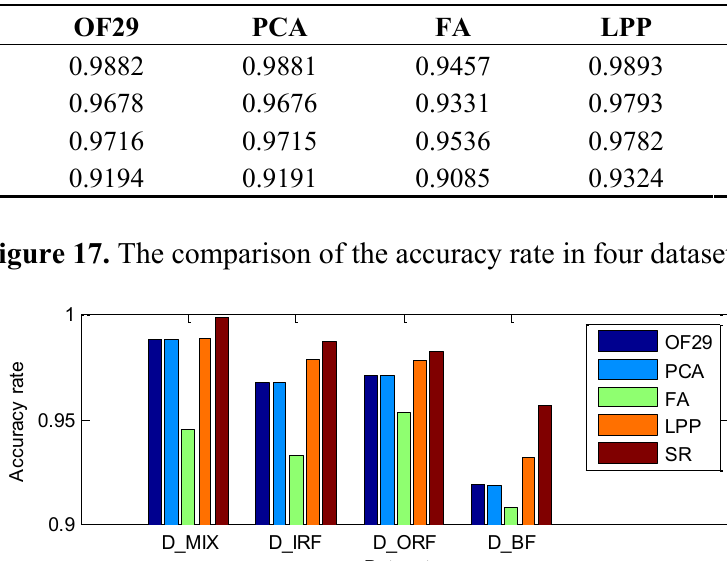
Table 4. The accuracy rate of classification by K -Means in four datasets.